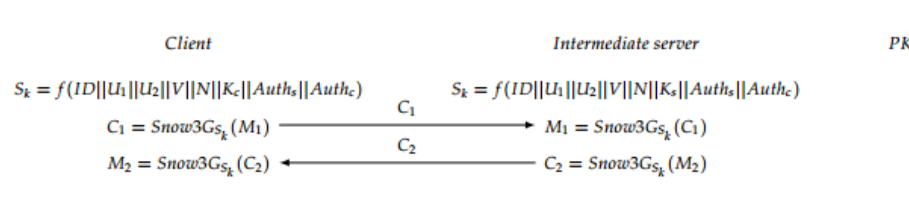
Figure 7. Session key